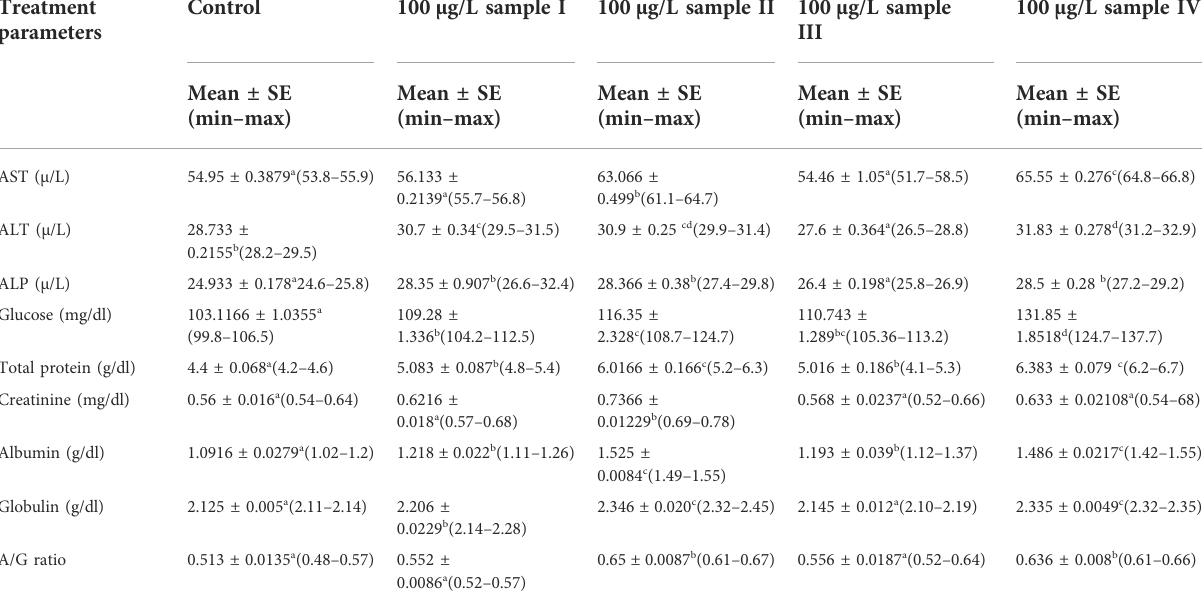
Data are represented as means ± SE. Values with a different superscript letter in the same row for each parameter are signi fi cantly different ( p < 0.05).